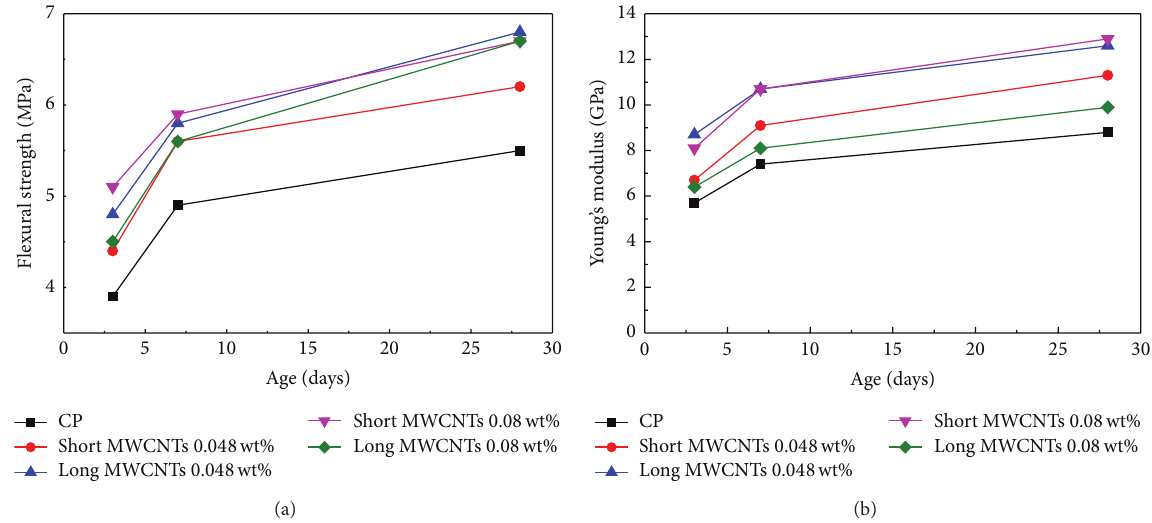
Figure 5: Effect of different types (short and long) of MWCNTs and concentration on the flexural strength (a) and Young’s modulus of cement paste (b)